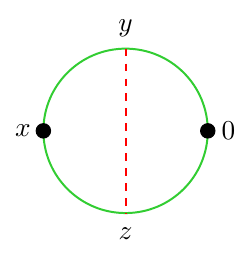
Figure 8 . Symmetry factor is 1.